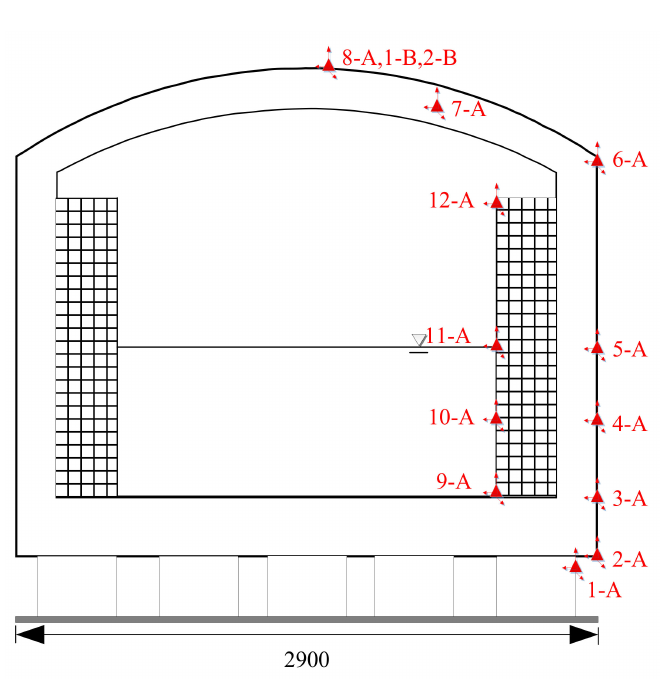
Figure 6. Sensor